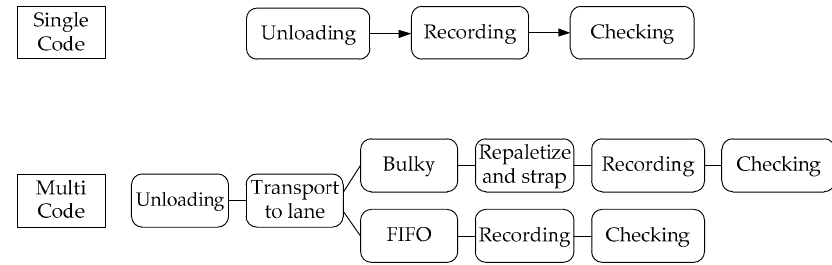
Figure 7. Characterization of the initial state through a process mapping.